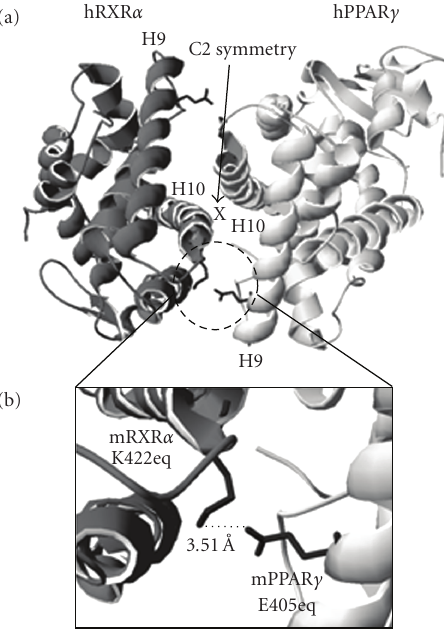
Figure 4: (a) Ribbon drawing of hRXR α /hPPAR γ LBD heterodimer (PDB 3E00, also see Figure 2). (b) The detail view of the equivalent amino acid sidechains of mouse RXR α K422 and mouse PPAR γ E405. The shortest distance between the negative (side chain carboxyl group of E405) and positive (side chain amino group of K422) charges is also